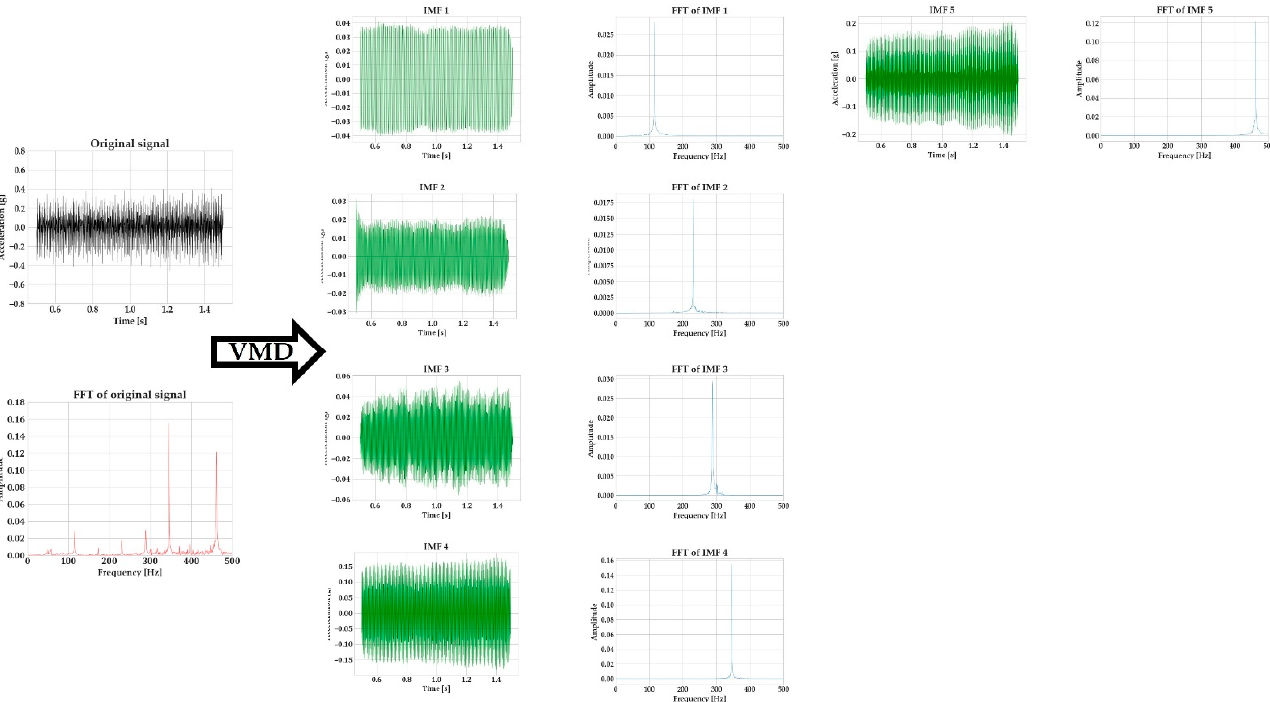
Figure 12. ROC curve of chatter detector.